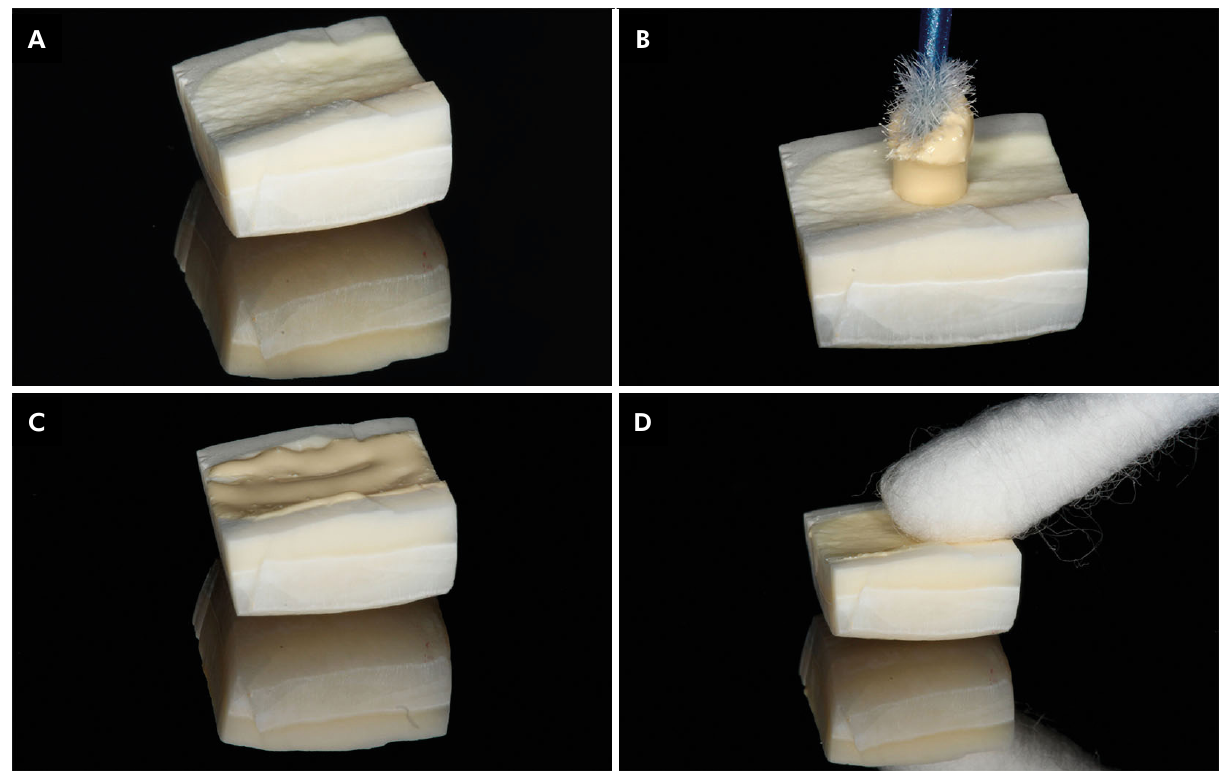
Figure 1. (A) specimen preparation; (B) the epoxy resin-based sealer application; (C) endodontic sealer applied to the dentin; (D) dentin surface